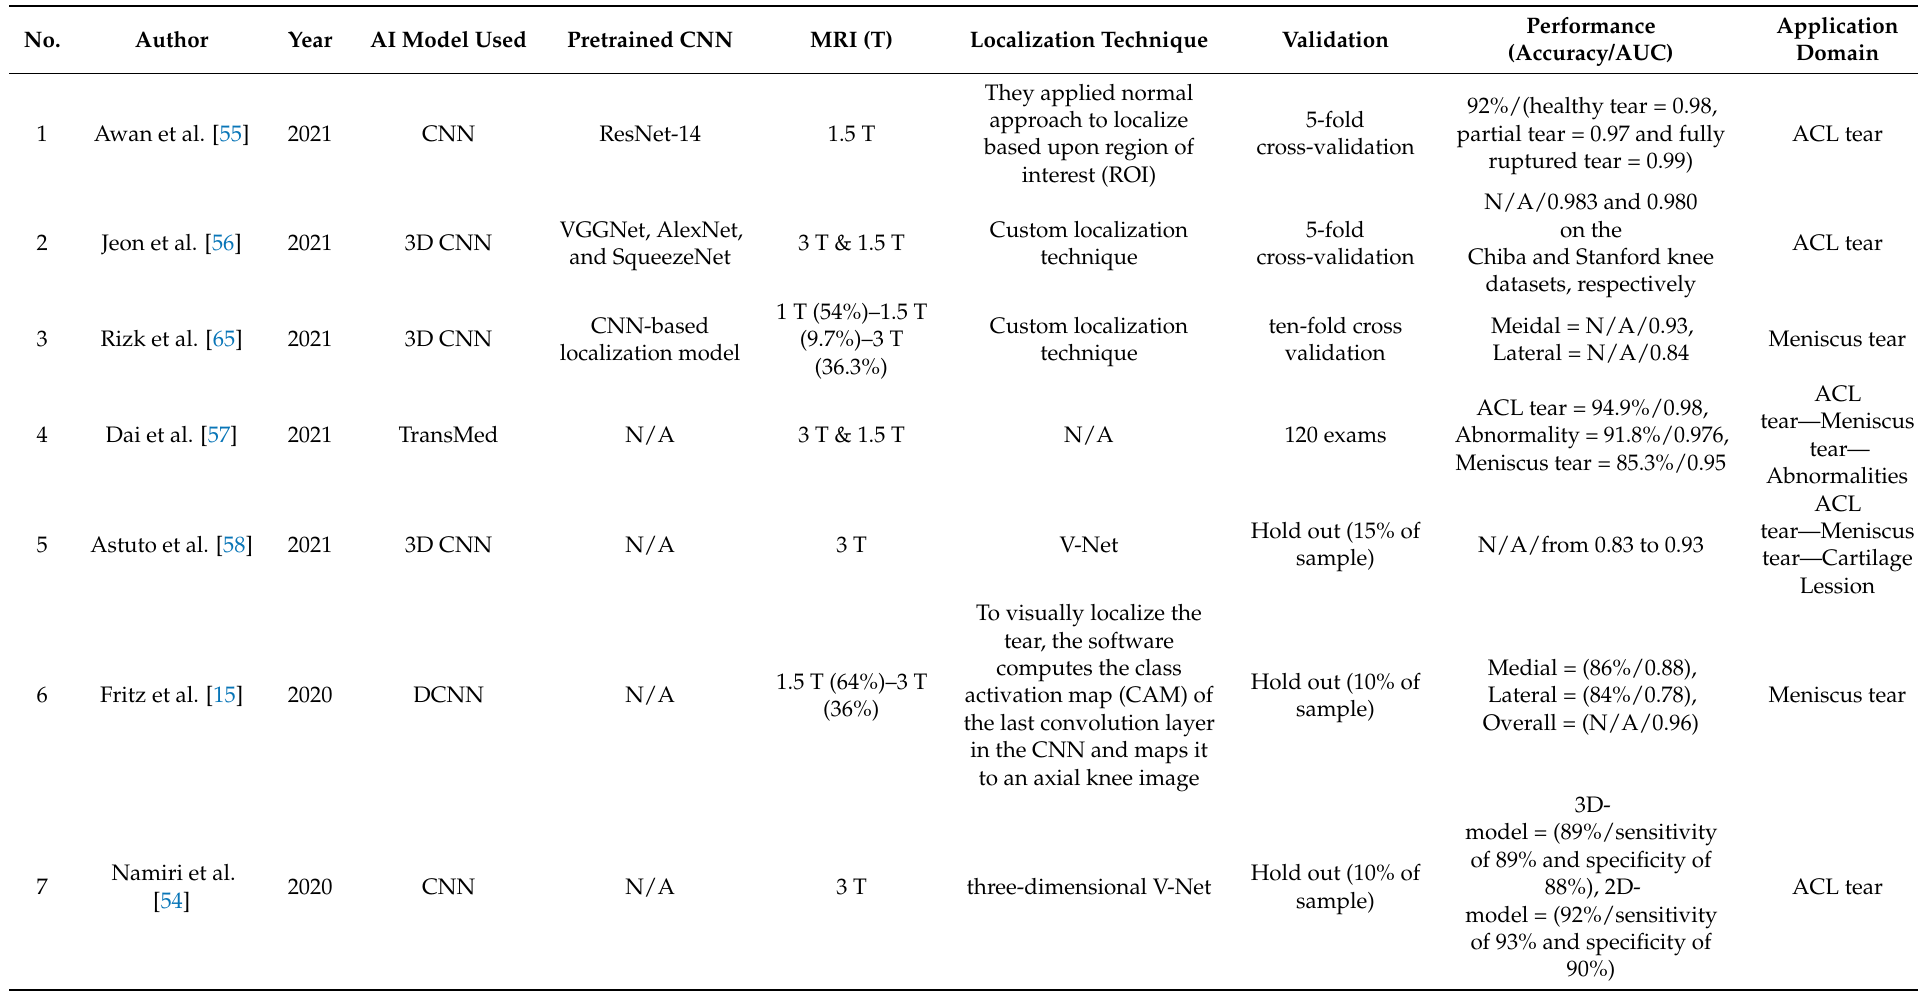
Table 2. Results of